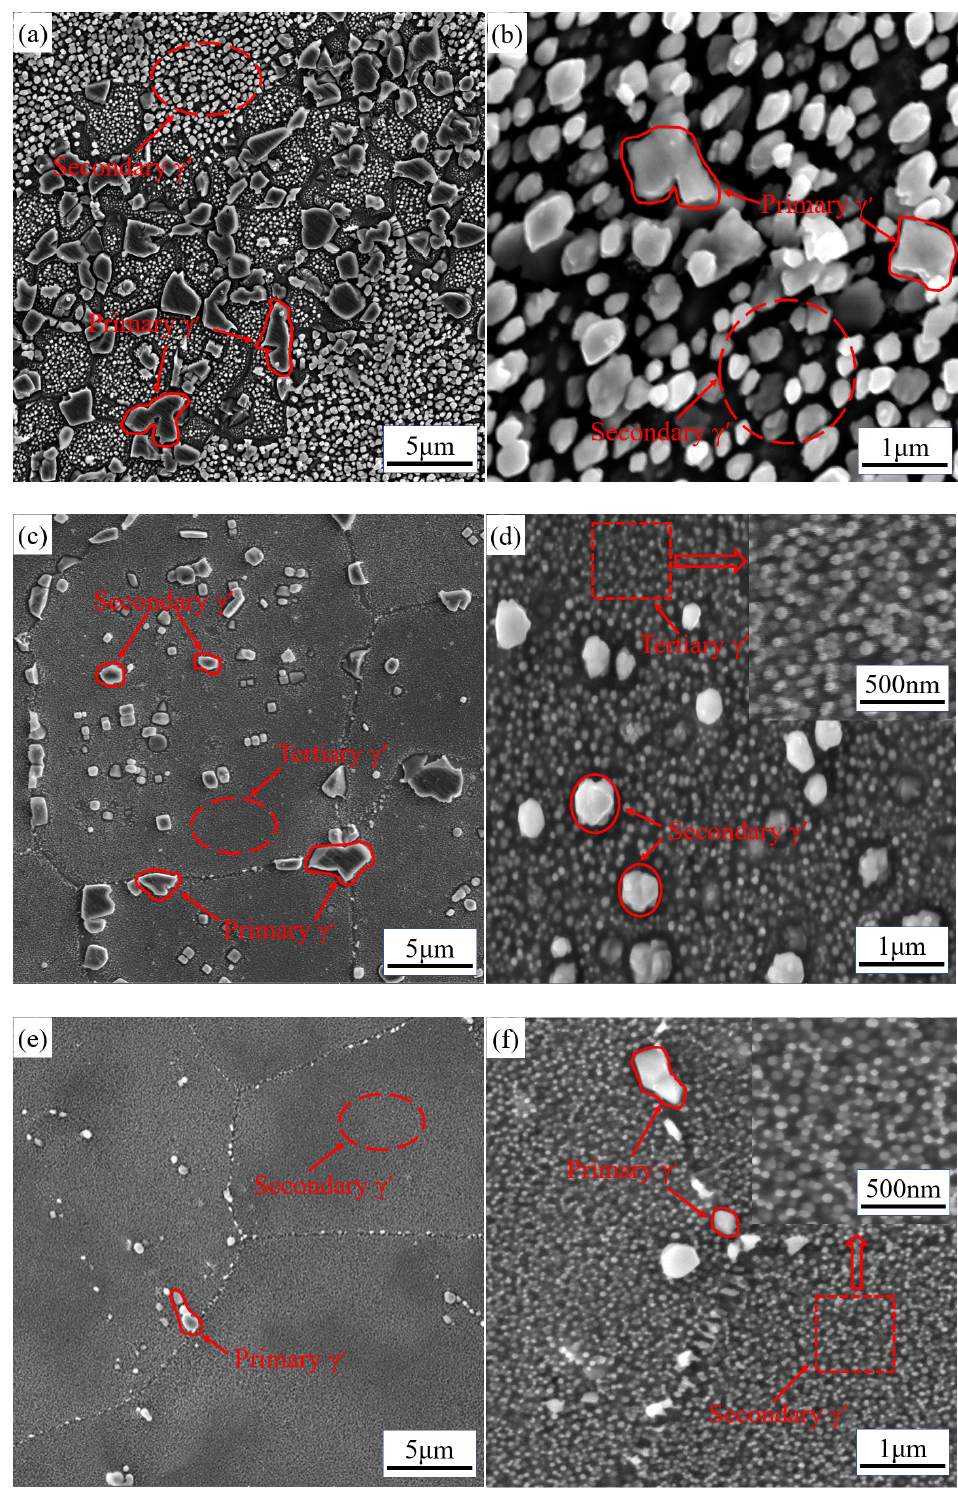
Figure 3. Morphology of γ′ precipitates after solution treatment for 10 h at different temperatures by AC: ( a , b ) 1060 °C, ( c , d ) 1080 °C, ( e , f ) 1100 °C. The grain size is affected by the degree of recrystallization and solubility of precipitates. At 1060 °C, a large amount of undissolved primary γ′ precipitates on the grain boundary seriously hinder the grain boundary migration process, resulting in a larger grain size and smaller degree of recrystallization. With the increase of temperature (1080